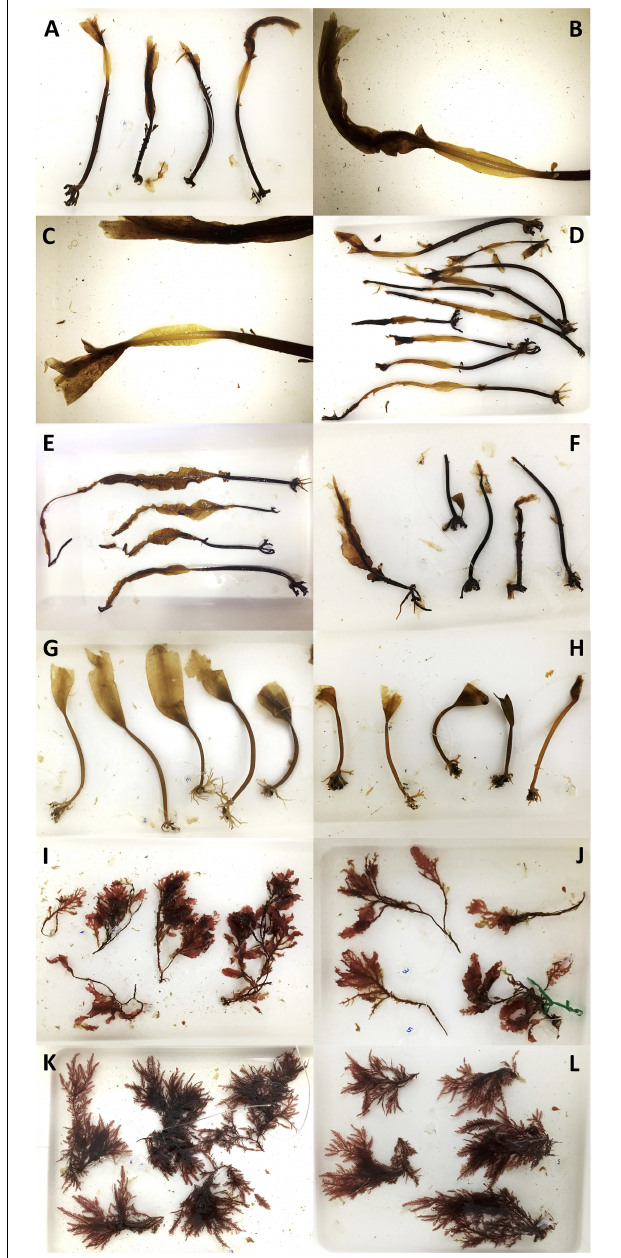
FIGURE 2 | Pictures of thalli after 4 months in darkness at either 3 or 8 ◦ C. Alaria esculenta at 3 ◦ C the last day of darkness (A) , [ (B,C) , detail] and after 1 week (D) and 2 months (E) of light return (D) . Alaria esculenta at 8 ◦ C the last day of darkness (F) . Saccharina latissima at 3 ◦ C (G) and 8 ◦ C (H) the last day of darkness. Phycodrys rubens at 3 ◦ C (I) and 8 ◦ C (J) the last day of darkness. Ptilota gunneri at 3 ◦ C (K) and 8 ◦ C (L) the last day of darkness.